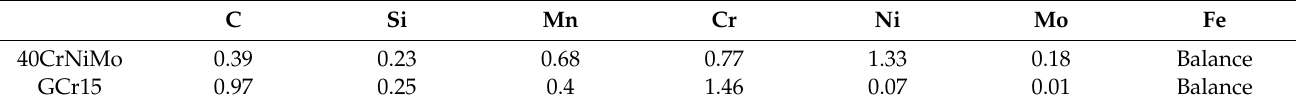
Table 1. Element content